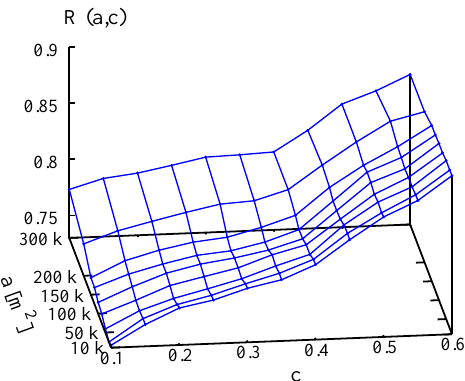
Figure 11. Values of the AUC ROC calculated for LS maps estimated using SU partitions derived for different combination of the a and c user-defined modeling parameters.